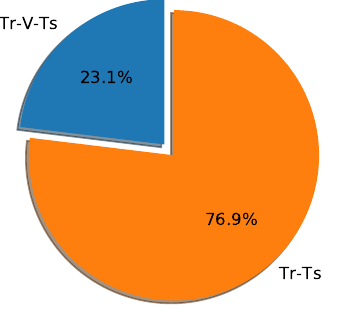
Figure 9. Overall distribution of training-testing (Tr-Ts) and training-validation-test splits (Tr-V-Ts) applied in CNN